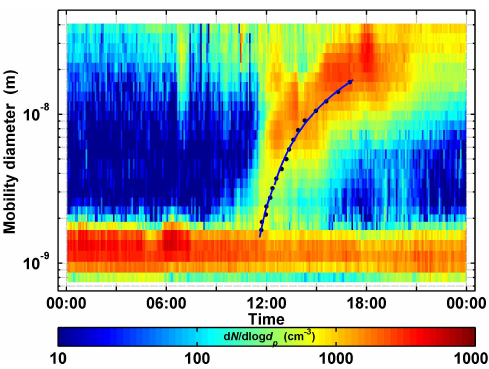
Fig. 6. Size spectra of negative air ions measured at Hyyti¨al¨a on 5 May 2007. Black dots represent locations of maxima of number concentrations in each size bin of the instrument. The solid line is a linear fit to those points. Growth rate of the particles is 2.1nm/h in size range 1.5 to 3nm, and 2.9nm/h from 3 to 20nm.